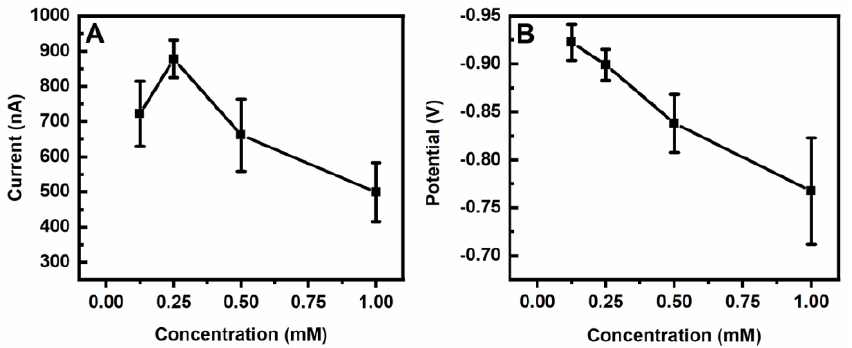
Figure 1. Dependence of the differential pulse voltammetry peak heights ( A ) and potential ( B ) of H 2 O 2 (200 μM) on the ITO electrodes modified with different concentrations of HAuCl 4 ·3H 2 O by electroplating. The average values and standard deviations were obtained based on 6 results.